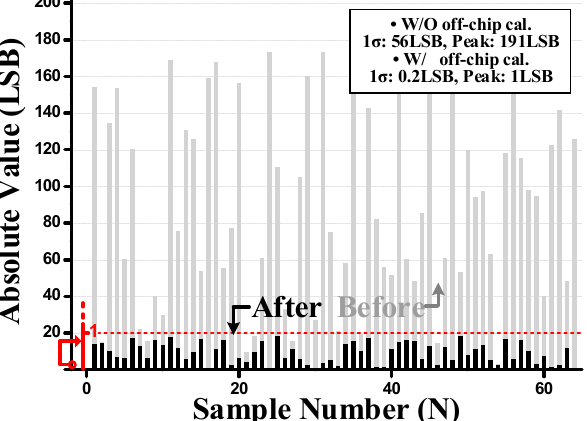
Figure 12. Pixel fixed pattern noise of the prototype chip.